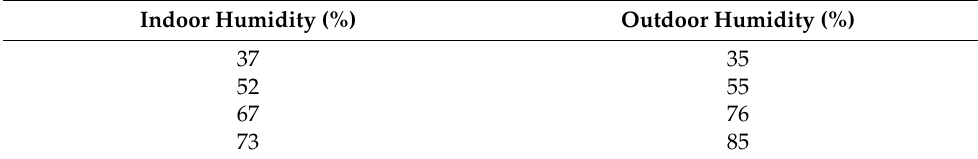
Table 5. Indoor and outdoor humidity for the classroom simulation chamber (inside the real-scale environmental chamber).